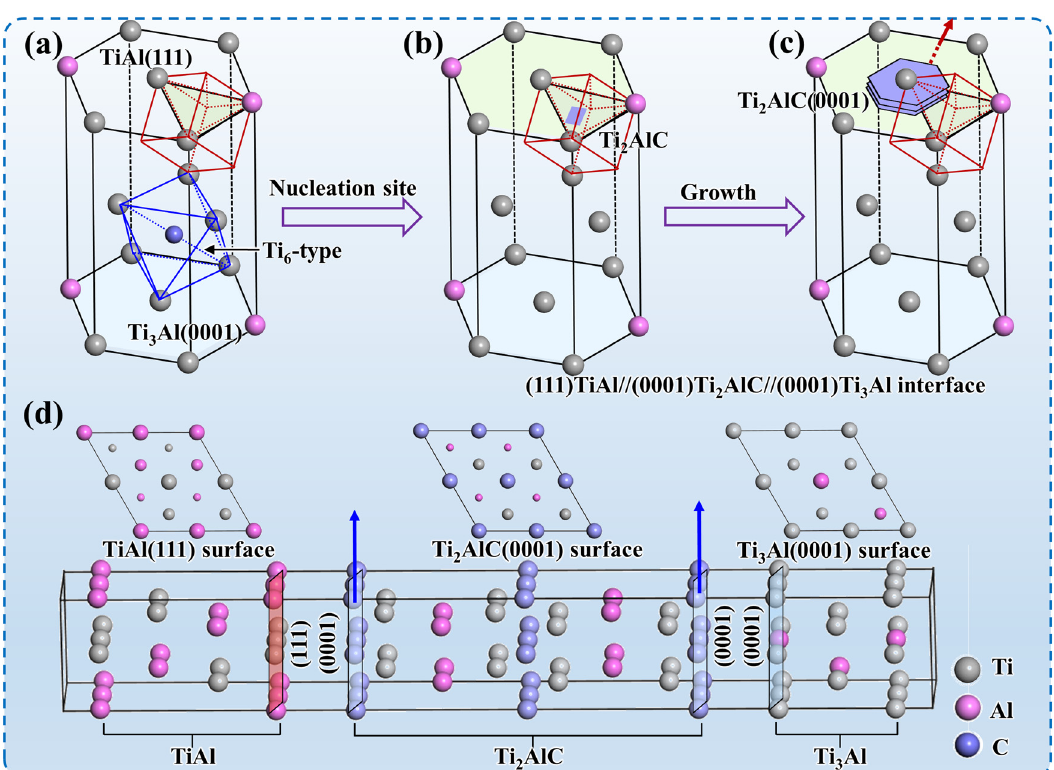
Figure 8: The schematic illustration for the nucleation and growth mechanism of Ti 2 AlC nano - precipitates: ( a ) the TiAl/Ti 3 Al interface and Ti 3 Al with Ti 6 - type octahedral interstice; ( b ) the nucleation of Ti 2 AlC; ( c ) the growth of Ti 2 AlC; and ( d ) the surface of TiAl ( 111 ) , Ti 2 AlC ( 0001 ) , and Ti 3 Al ( 0001 ) and the Ti 3 Al/Ti 2 AlC/TiAl